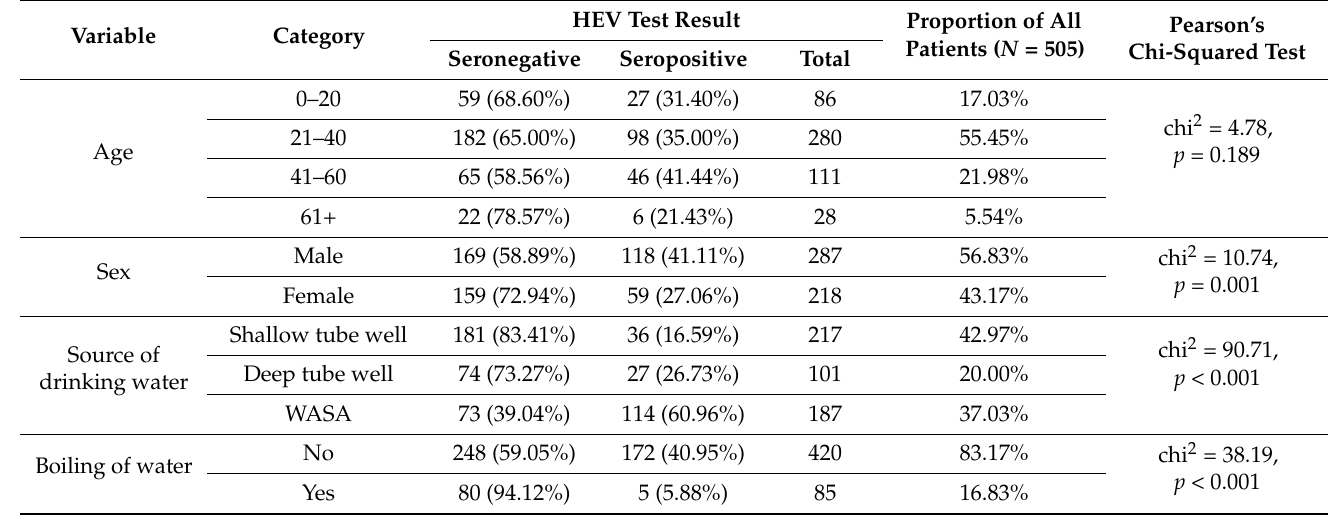
Table 2. Summary of HEV survey results and associated Pearson’s chi-squared test results.